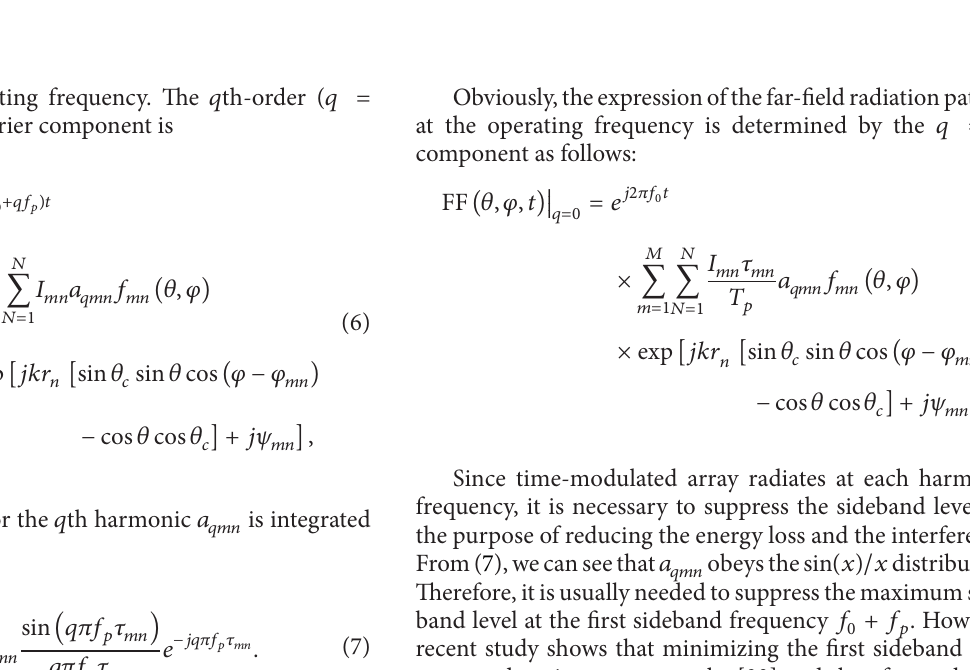
Figure 1: A graphical representation of the antenna element distribution conformal to the conical surface. (a) 3D structure. (b) Sectional View. (c) Cross sectional view for the bottom